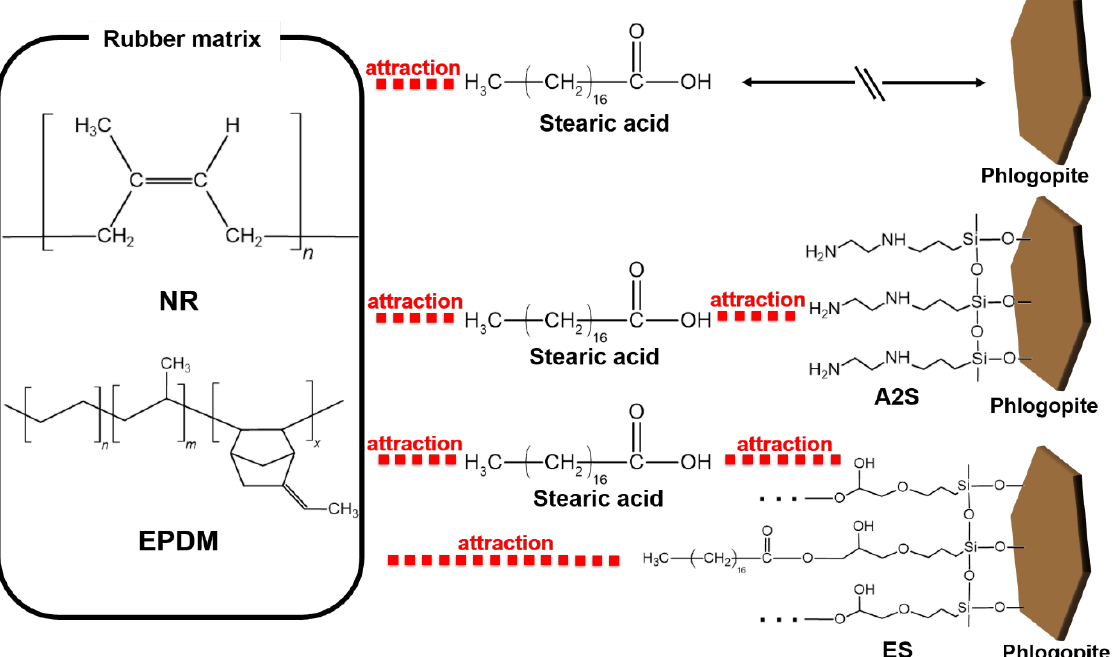
Figure 8. Mechanisms of physical and chemical interactions among rubber matrices, stearic acid, and functionalized phlogopite. n , m , and x indicate the number of each repeating unit.